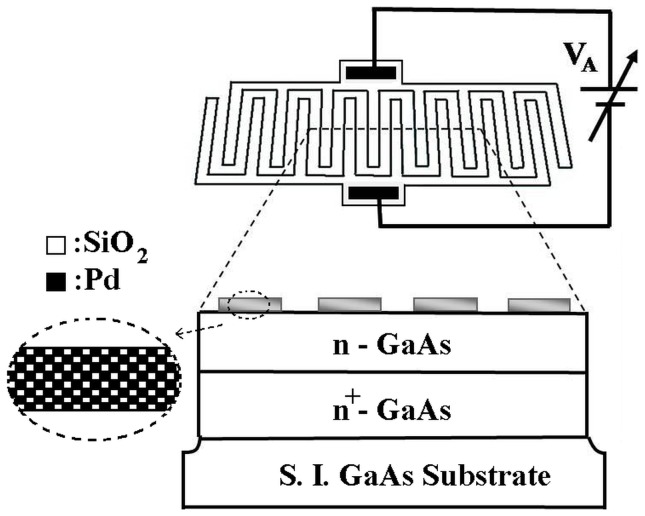
Schematic view of a M-MSM diodes with two multi-finger Pd/SiO2 mixture electrodes.